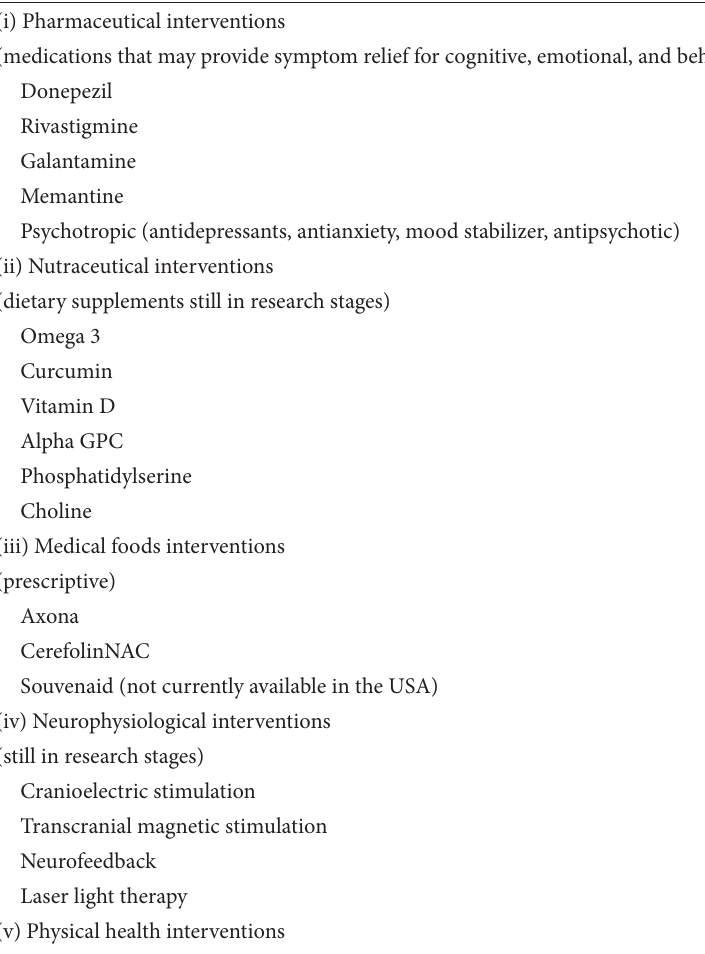
Table 2: Management of dementia: eight intervention areas to be